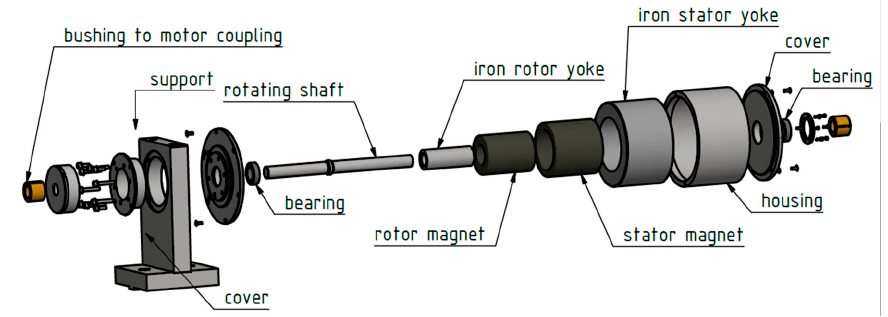
Figure 6. Explosion view of the prototyped magnetic spring design.